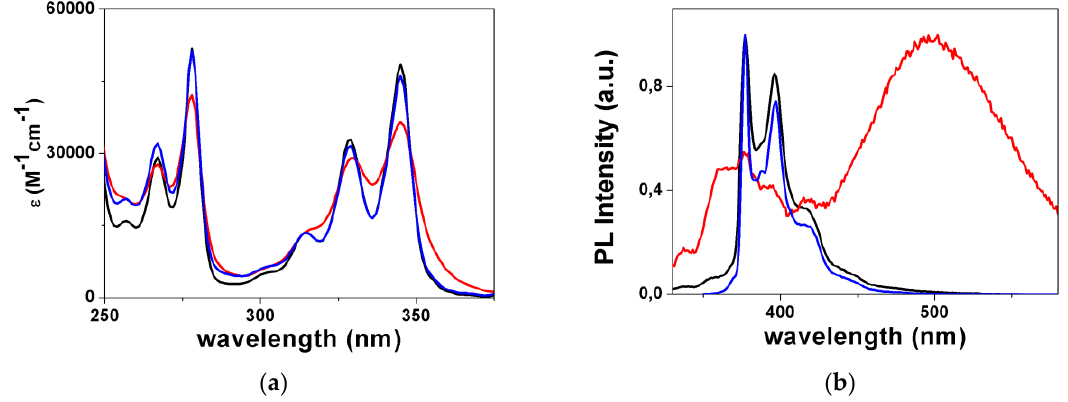
Figure 4. ( a ) Absorption spectra in CHCl 3 solution of L 2 (black line), [L 2 H] + (red line), and CuL 2 (blue line); ( b ) Emission spectra in CHCl 3 solution of L 2 (black line), [L 2 H] + (red line), and CuL 2 (blue line).